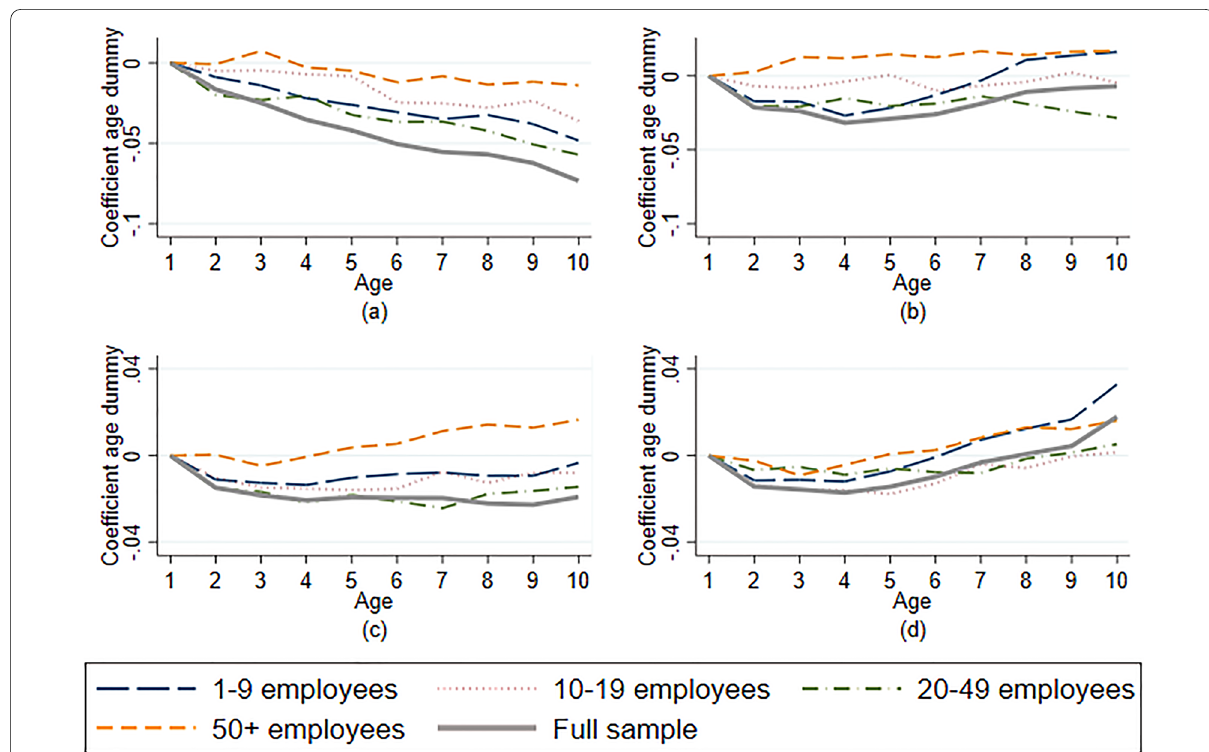
Fig. 18 Evolution of the within-cohort wage dispersion for different size classes, as measured by the coefficient of the age dummies. a Displays the sample with surviving and exiting establishments that entered between 1996 and 2008 (referring to specification (1) in Table 1). b Displays the sample with only surviving establishments that entered between 1996 and 2008 (referring to specification (2) in Table 1). c Displays the sample with surviving and exiting establishments that entered before 1996 (referring to specification (3) in Table 1). d Displays the sample with only surviving establishments that entered before 1996 (referring to specification (4) in Table 1). For the sake of clarity, I only show point estimates